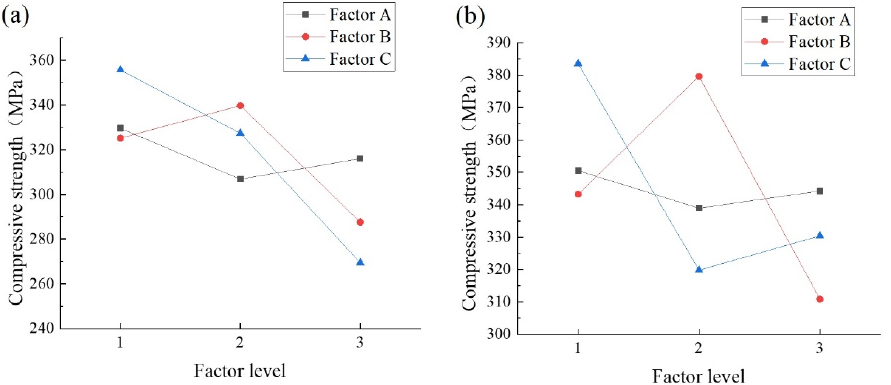
Figure 2. K -value of the ultimate compressive strength of the cube specimens. ( a ) Compressive strength at 7 d; ( b ) Compressive strength at 28 d.